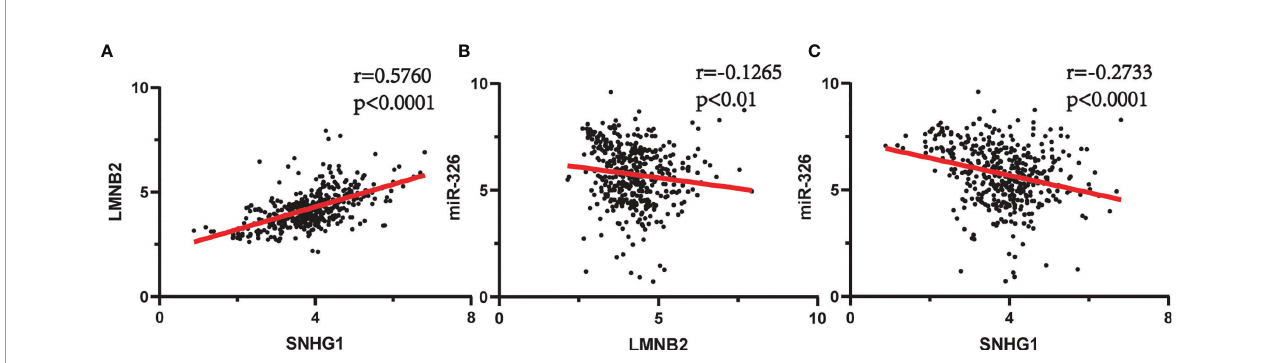
FIGURE 4 | Spearman ’ s correlation analysis between SNHG1 , miR-326 , and LMNB2 in hepatocellular carcinoma (HCC). (A) SNHG1 is positively correlated with LMNB2 (r = 0.5760, p < 0.0001). (B) miR-326 is negatively correlated with LMNB2 (r = 0.1256, p < 0.01). (C) SNHG1 is negatively correlated with miR-326 (r = 0.2733, p